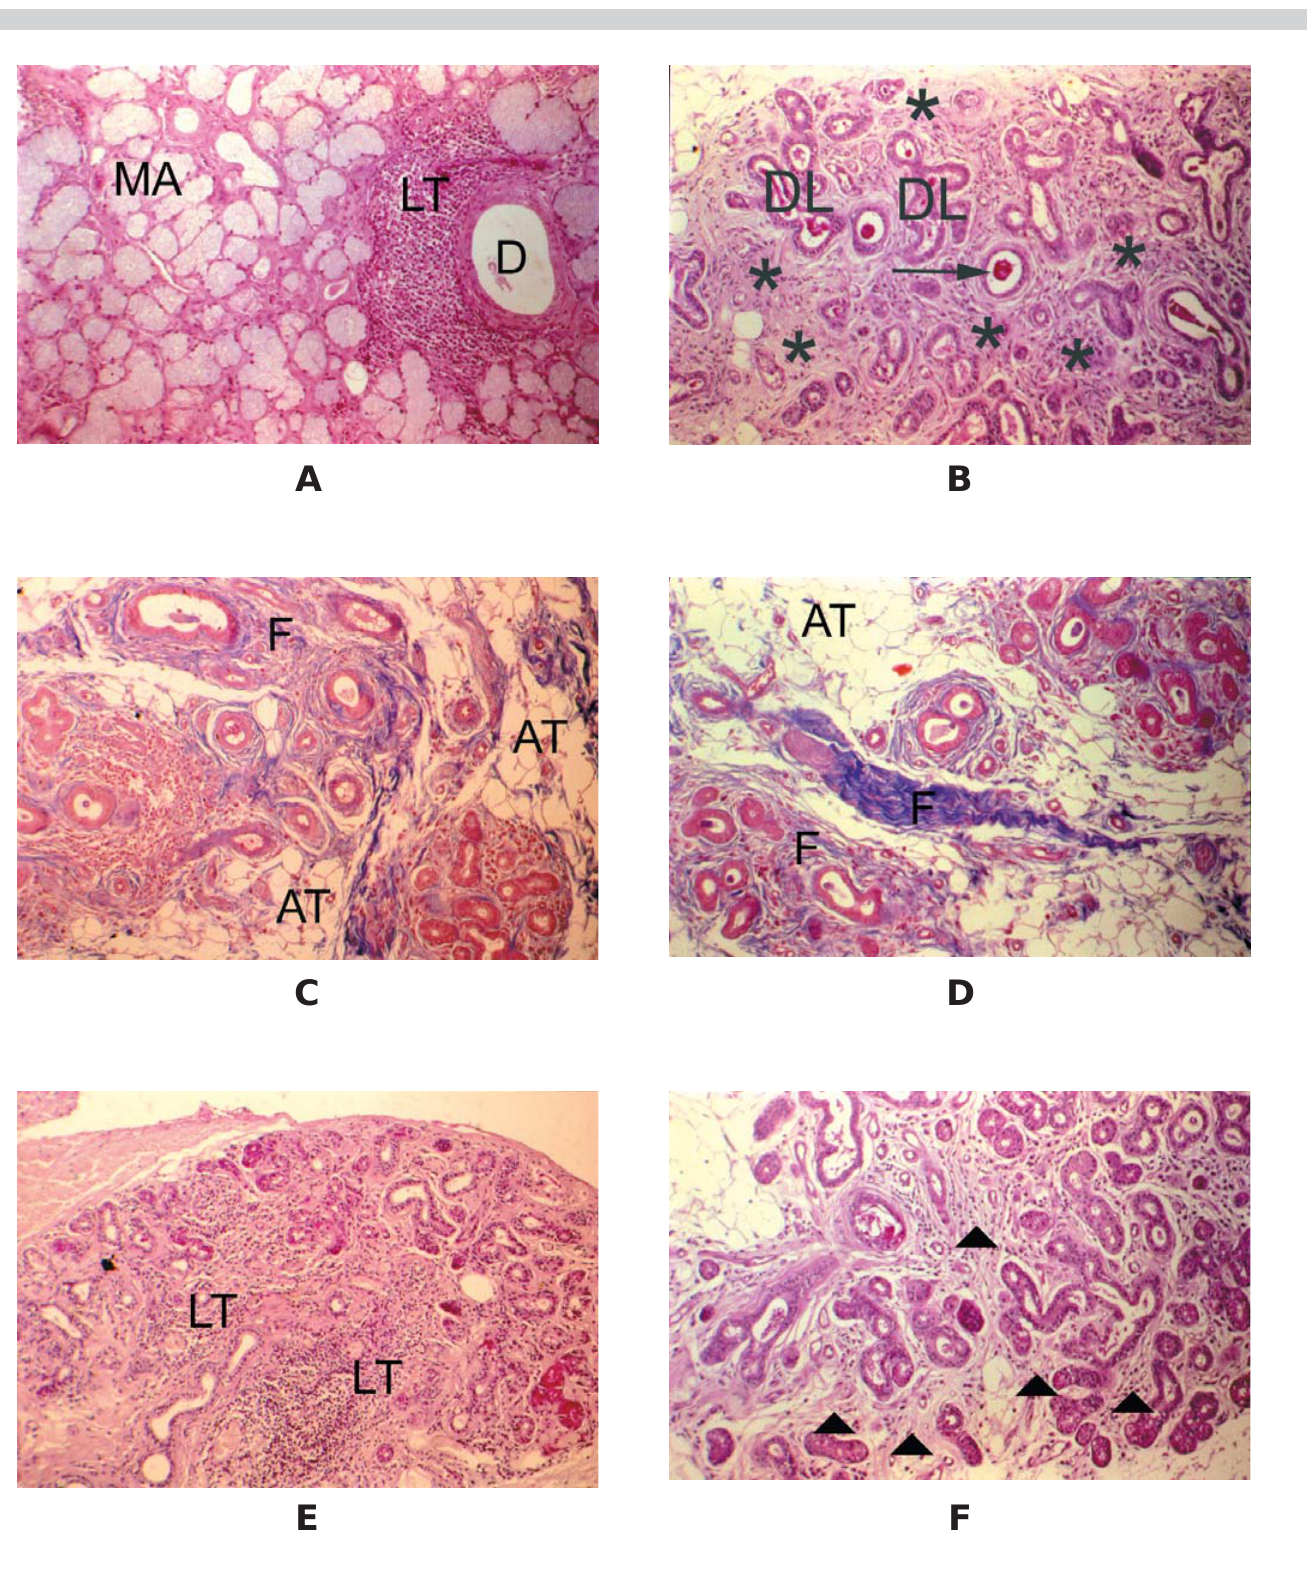
FIGURE 2- Main microscopic aspects in the sublingual glands. A: Normal gland with mucous acini (MA) and normal lymphoid tissue (LT) around an excretory duct (D). PAS. Original Magnification - 40X. B: Intense acinar atrophy (*), hyperplasia of duct-like structures (DL) and retention of intraductal mucus ( → ) PAS. Original Magnification - 40x. C: Moderate fibrosis (F) with infiltration of adipose tissue (AT) among duct-like structures. Mallory. Original Magnification - 40x. D: Intense fibrosis (F) and infiltration of adipose tissue (AT). Mallory. Original Magnification - 40x. E: Disorganization and disappearance of lymphoid tissue (LT) among duct-like structures of an atrophic parenchyma. PAS. Original Magnification -16X. F: Disorganization and disappearance of lymphoid tissue ( (cid:24) ). PAS. Original Magnification -